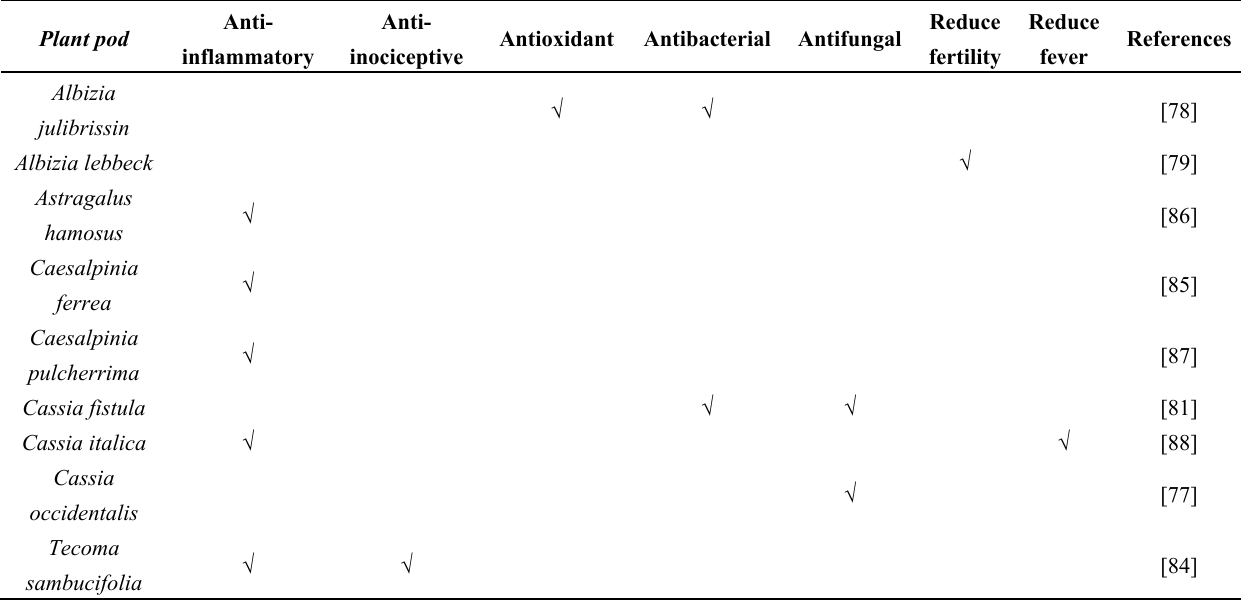
Table 2. Biological activity of Ethnobotanical Fruit